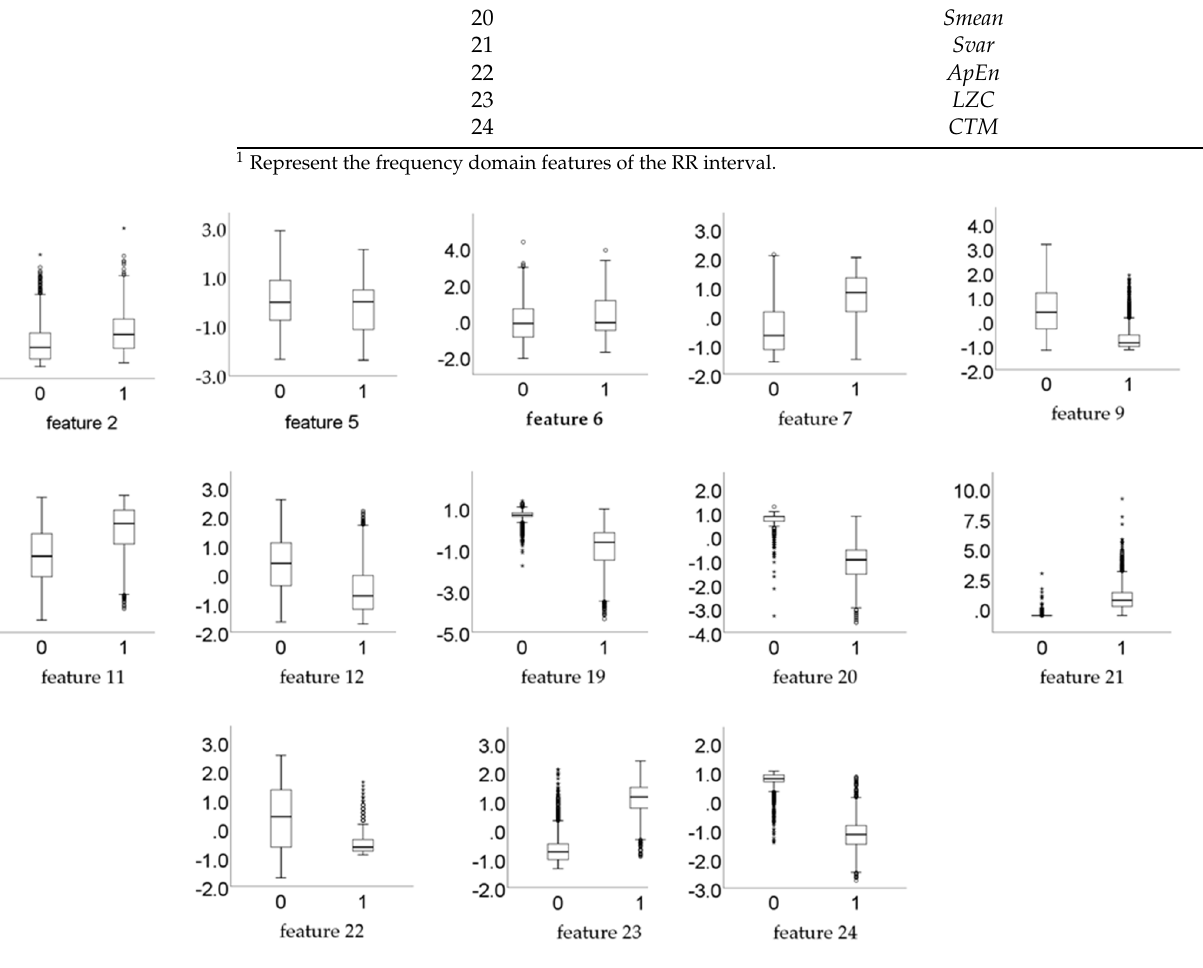
Figure 5. Box plots for the selected features corresponding to 0 and 1 classes, where 0 represents normal and 1 represents apnea. Table 4. Per-segment classification results of different classifiers on the Apnea-ECG